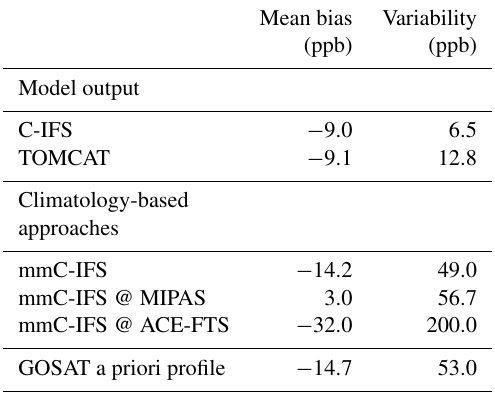
Table 1. Mean value and variability in the stratospheric column bias due to the different stratospheric extensions at the locations of MOZAIC airports. MIPAS is taken to be the reference truth. The documented “threshold” requirements of bias/systematic error (as a measure of accuracy) and random error (as a measure of precision) for satellite-based XCH 4 to be usable for CH 4 source/sink estima- tion are 10 and 34ppb respectively (Buchwitz et al., 2011). Mean bias